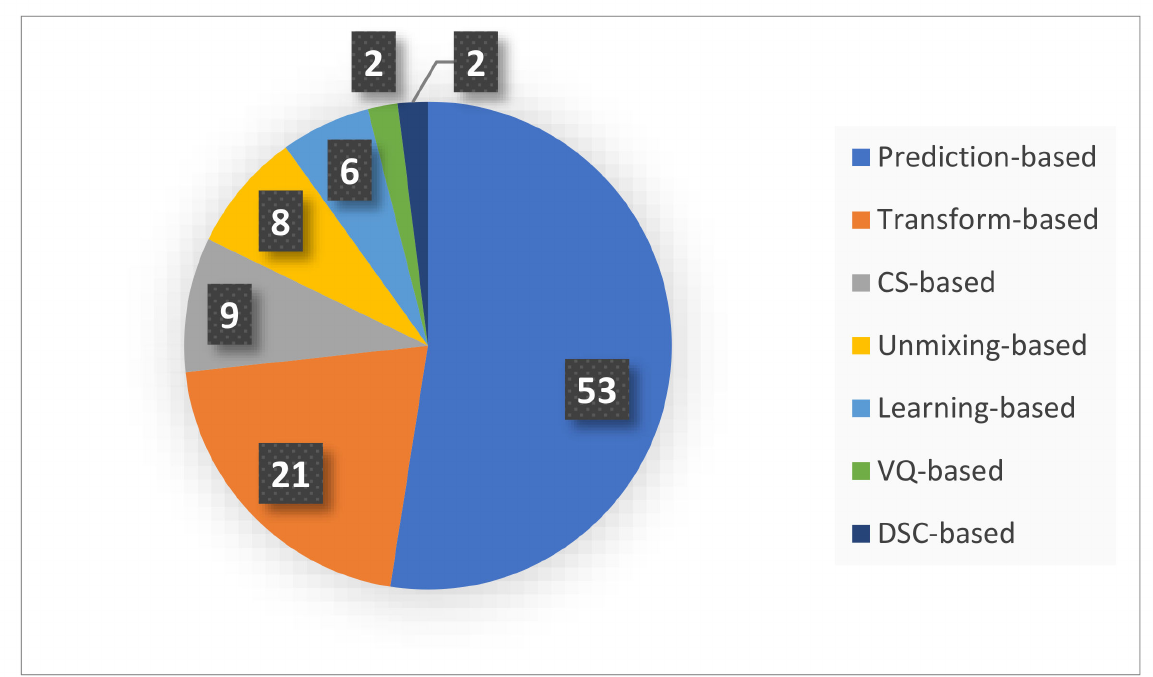
Figure 8. Chart showing the number of studies according to the compression algorithm class on which they are